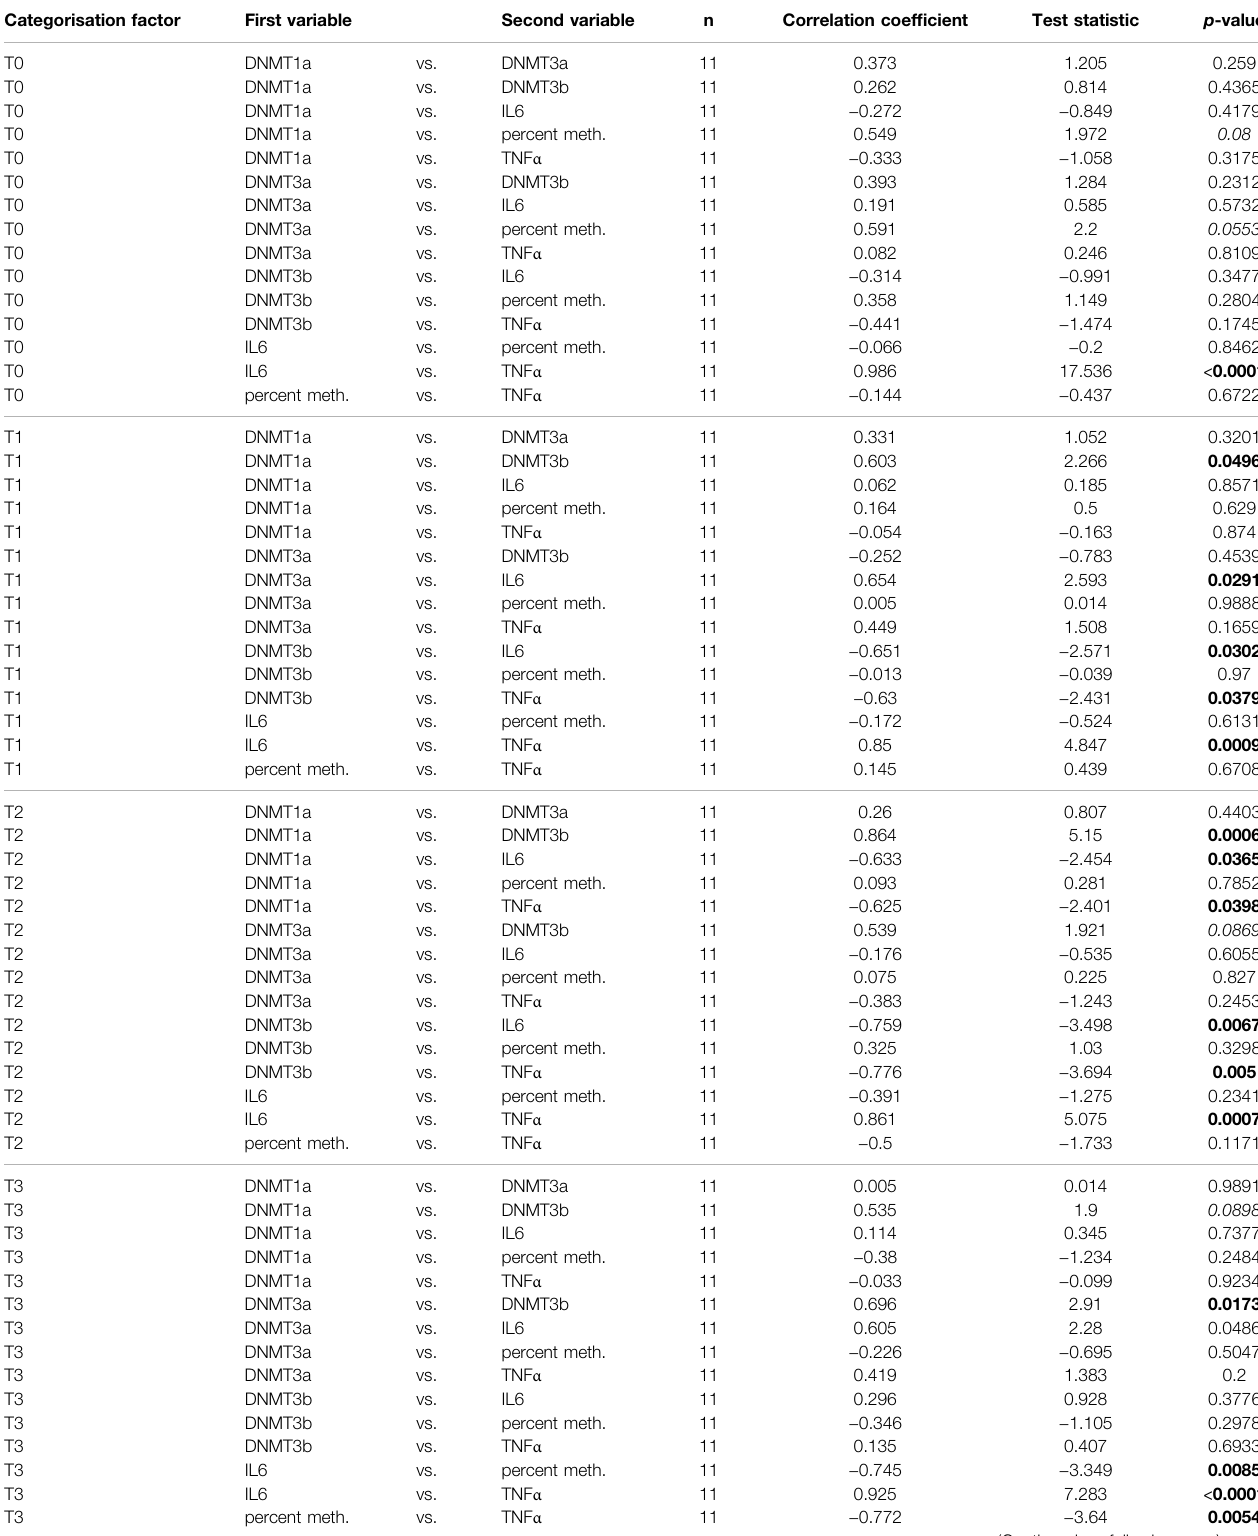
TABLE3| CorrelationanalysisbetweenDNAmethylationandDNMTandcytokineexpression.Signi fi cant p valuesaredisplayedinbold.0.05 < p < 0.1valuesaredisplayedin